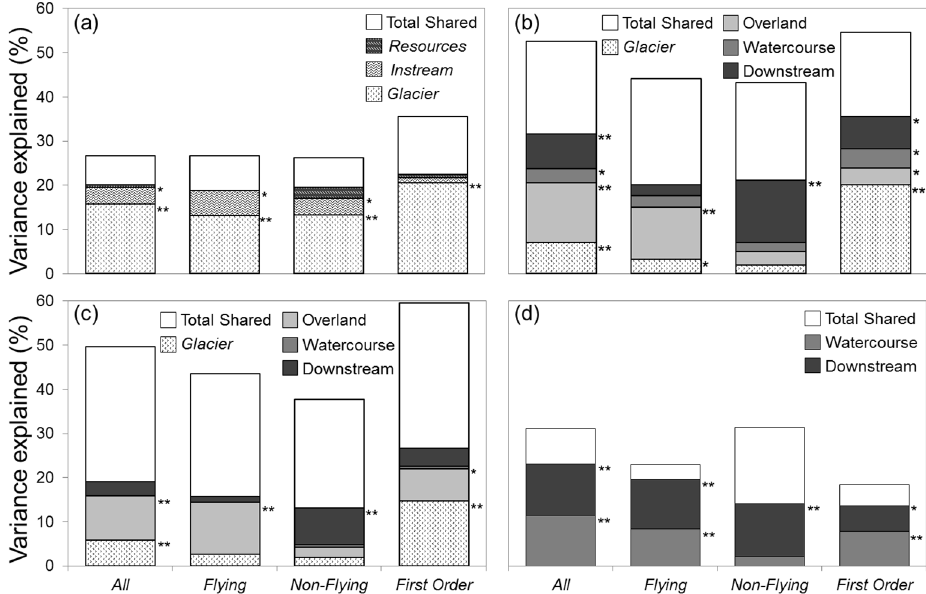
Fig 2. Results of variation partitioning analyses. Results of analyses performed on ( a ) the two environmental components Instream and Resources and the component Glacier , ( b ) the three spatial eigenfunction-based variables computed using overland, watercourse, downstream geographical distances and the environmental component Glacier , ( c ) the three spatial eigenfunction-based variables computed using overland, watercourse, downstream altitudinal distances and the environmental component Glacier , and ( d ) the two spatial eigenfunction-based variables based on watercourse and downstream glaciality distances. All analyses were performed for the four taxon matrices ( All taxa , Flying taxa , Non-flying taxa , and First-order taxa ). Figure shows the amount of variation (%) in the structure community that is uniquely explained by each explanatory variable as well as the total shared variance (all the shared components between two, three and four explanatory variables). The level of significance is indicated next to the bars ( ** P < 0.01, * P < 0.05, see S3 Appendix for